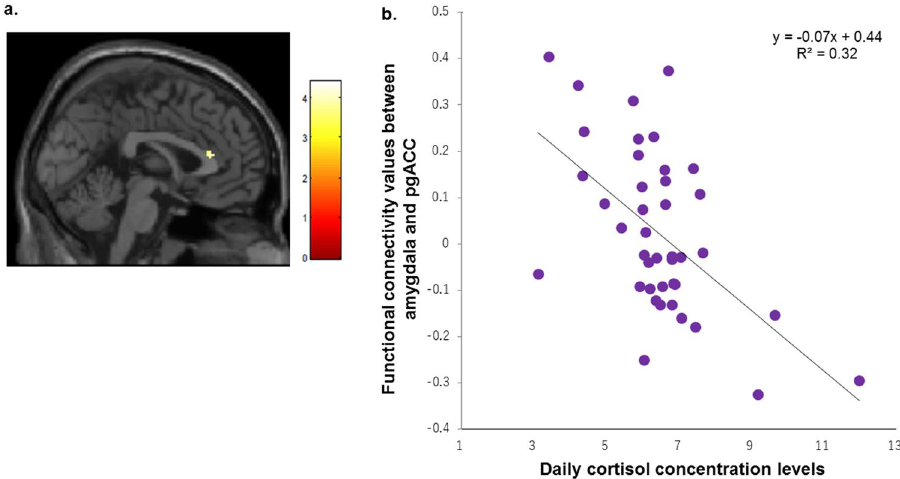
Figure 3. The pgACC exhibits diminished FC with the amygdala. ( a ) pgACC cluster found at MNI 0 30 14 (120 mm 3 ; T = 4.40, p < 0.001). Colour bar indicates T-value. ( b ) Scatter plot of the relationship between dCOR and amygdala-pgACC FC values in fearful faces processing (vs. neutral faces). Abbreviations: pgACC, perigenual anterior cingulate cortex; FC, functional connectivity; MNI, Montreal Neurological Institute space; dCOR, daily cortisol concentrations.